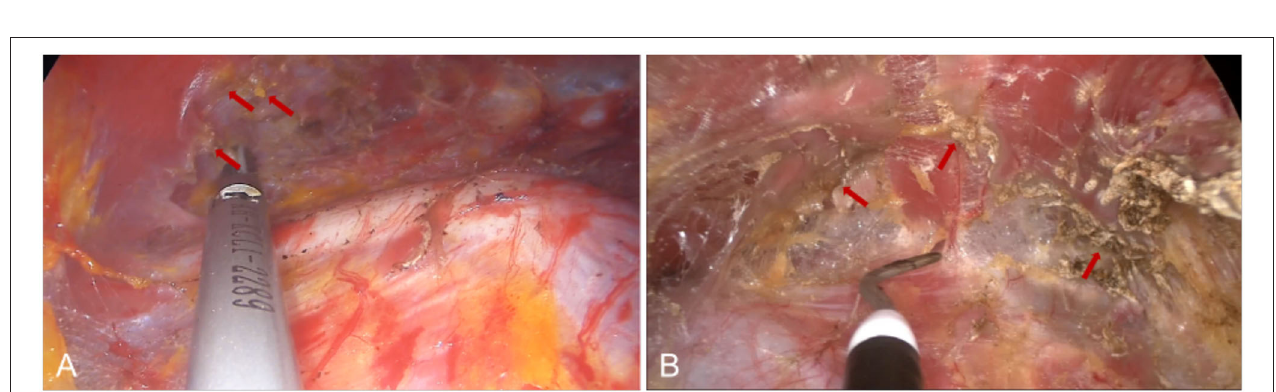
FIGURE 9 | Comparison of tissue cutting effects between ultrasonic scalpel and electric hook. (A) Arrows indicate small tissue damage after ultrasonic knife cutting tissue. (B) Destructive tissue damage after electric hook cutting.